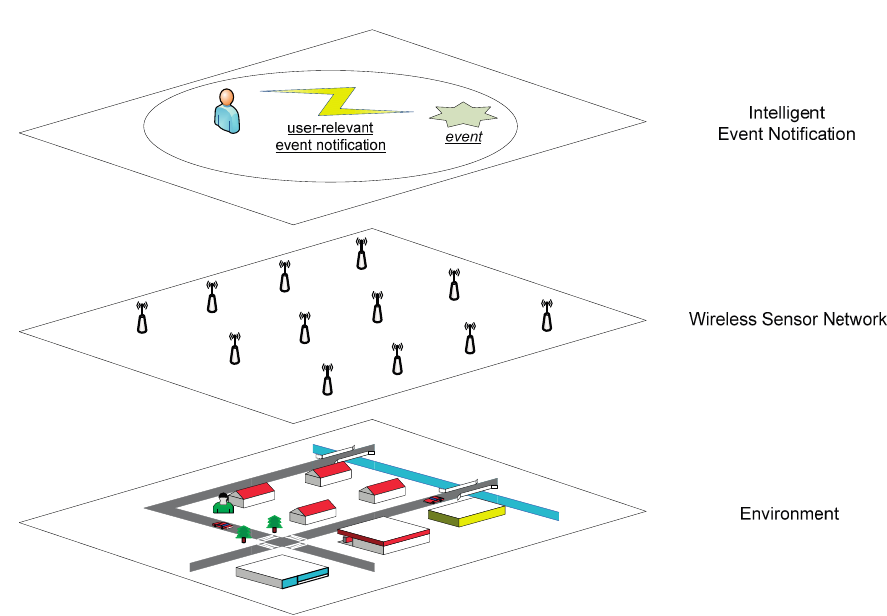
Figure 1. Scenario